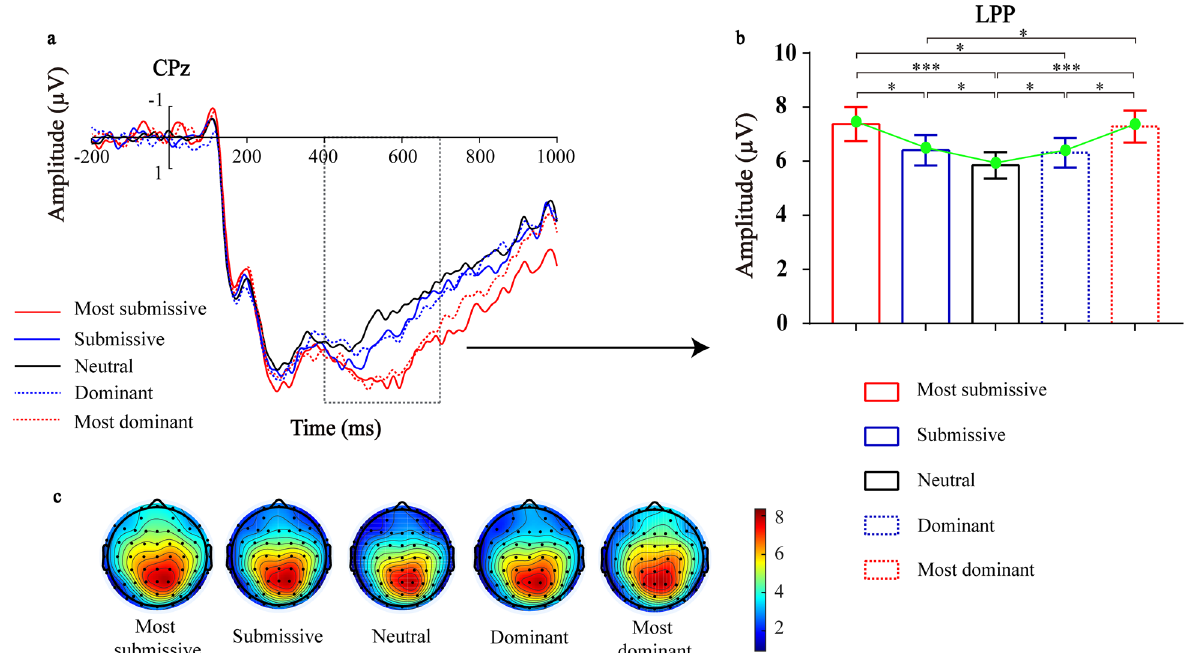
Figure 3. The LPP related to facial dominance evaluation. ( A ) The LPP over the centro-parietal region (CPz) as a function of dominance levels (− 3 SD, − 2 SD, 0 SD, + 2 SD, + 3 SD). ( B ) Bar plots illustrate the effect of dominance levels on the amplitude of the LPP over the centro-parietal region (CPz). Error bars indicate SEM, (* p < 0.05, *** p < 0.001). ( C ) Topographical voltage distributions within 400–700 ms centered on the peak of LPP elicited by faces with different levels of dominance. Positive isopotential lines are in red and negative isopotential lines are in